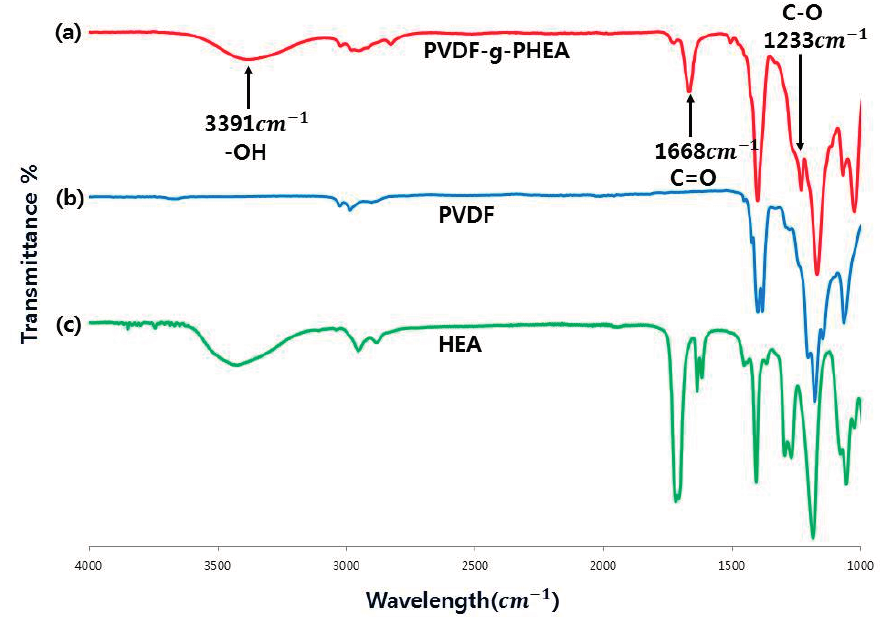
Figure 2. FT-IR spectra of